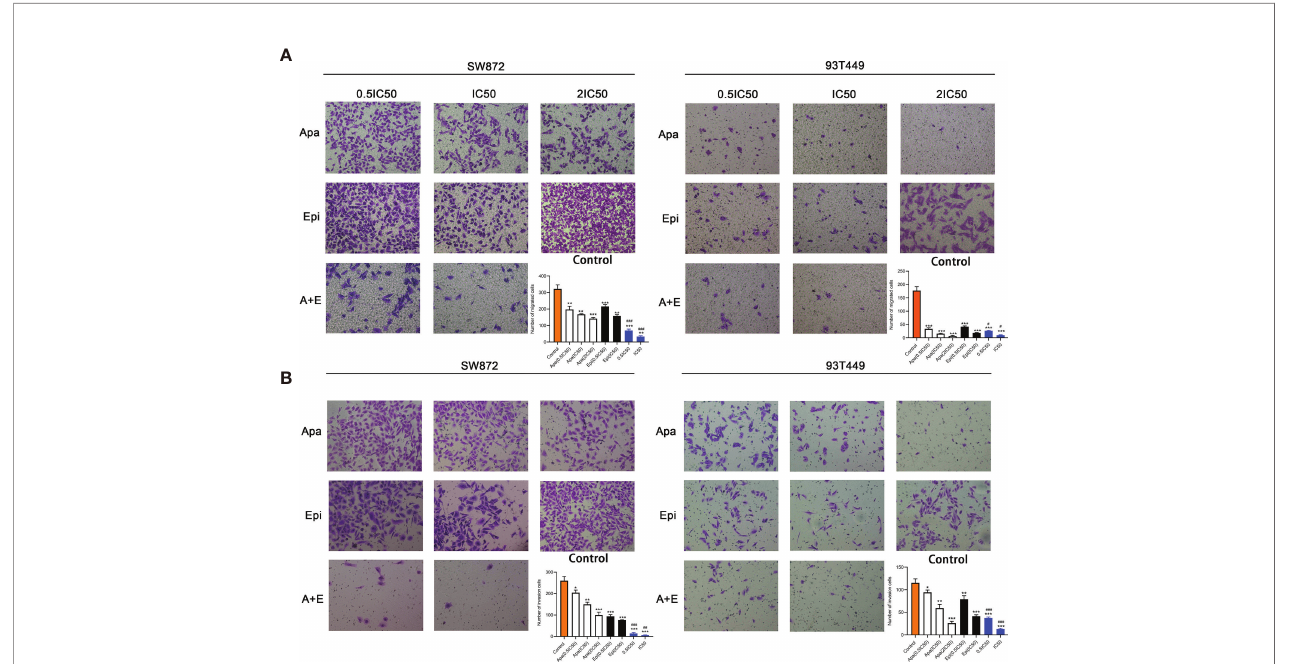
FIGURE 3 | Apatinib and its combination with Epirubicin inhibited migration and invasion of SW872 and 93T449 cells. (A) Transwell assays revealed that Apatinib and its combination with Epirubicin reduced the number of migrating liposarcoma cells. (B) Transwell assays revealed that Apatinib alone and its combination with Epirubicin reduced the number of invading liposarcoma cells. ×100 magni fi cation. */**/*** for comparison between treatment and control groups, *P < 0.05, **P < 0.01, ***P < 0.001; # / ## / /### for comparison between Apatinib group and combination group, # P < 0.05, ## P < 0.01, ### P < 0.001; Apa, Apatinib; Epi, Epirubicin; A +E, combination of Apa and